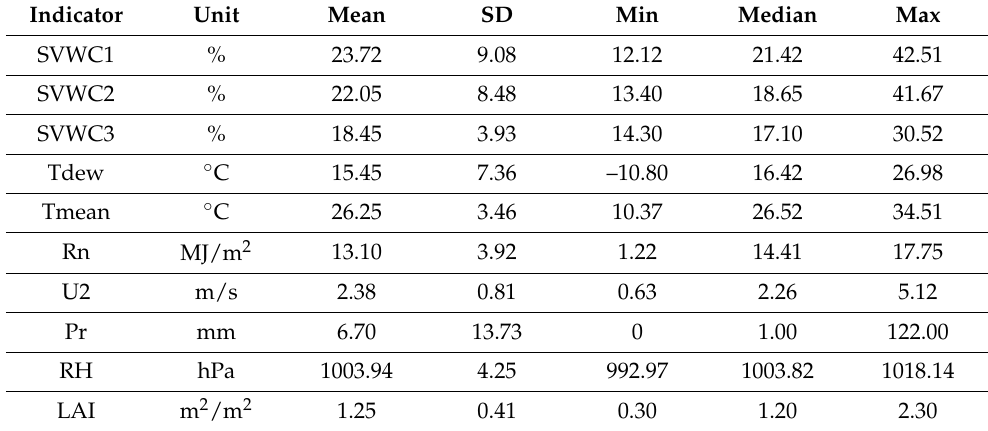
Table 8 lists the results for the statistical analysis of the meteorological, soil moisture, and LAI data obtained from 10 May to 8 August 2015 to 2019. Compared with the measured data statistically obtained in Table 7, the statistical results for Tmean, Rn, RH, and U2 were more similar, while the average daily precipitation was approximately 1.99 mm higher. Table 8. Statistics on the remote sensing data indicators for the maize growing areas